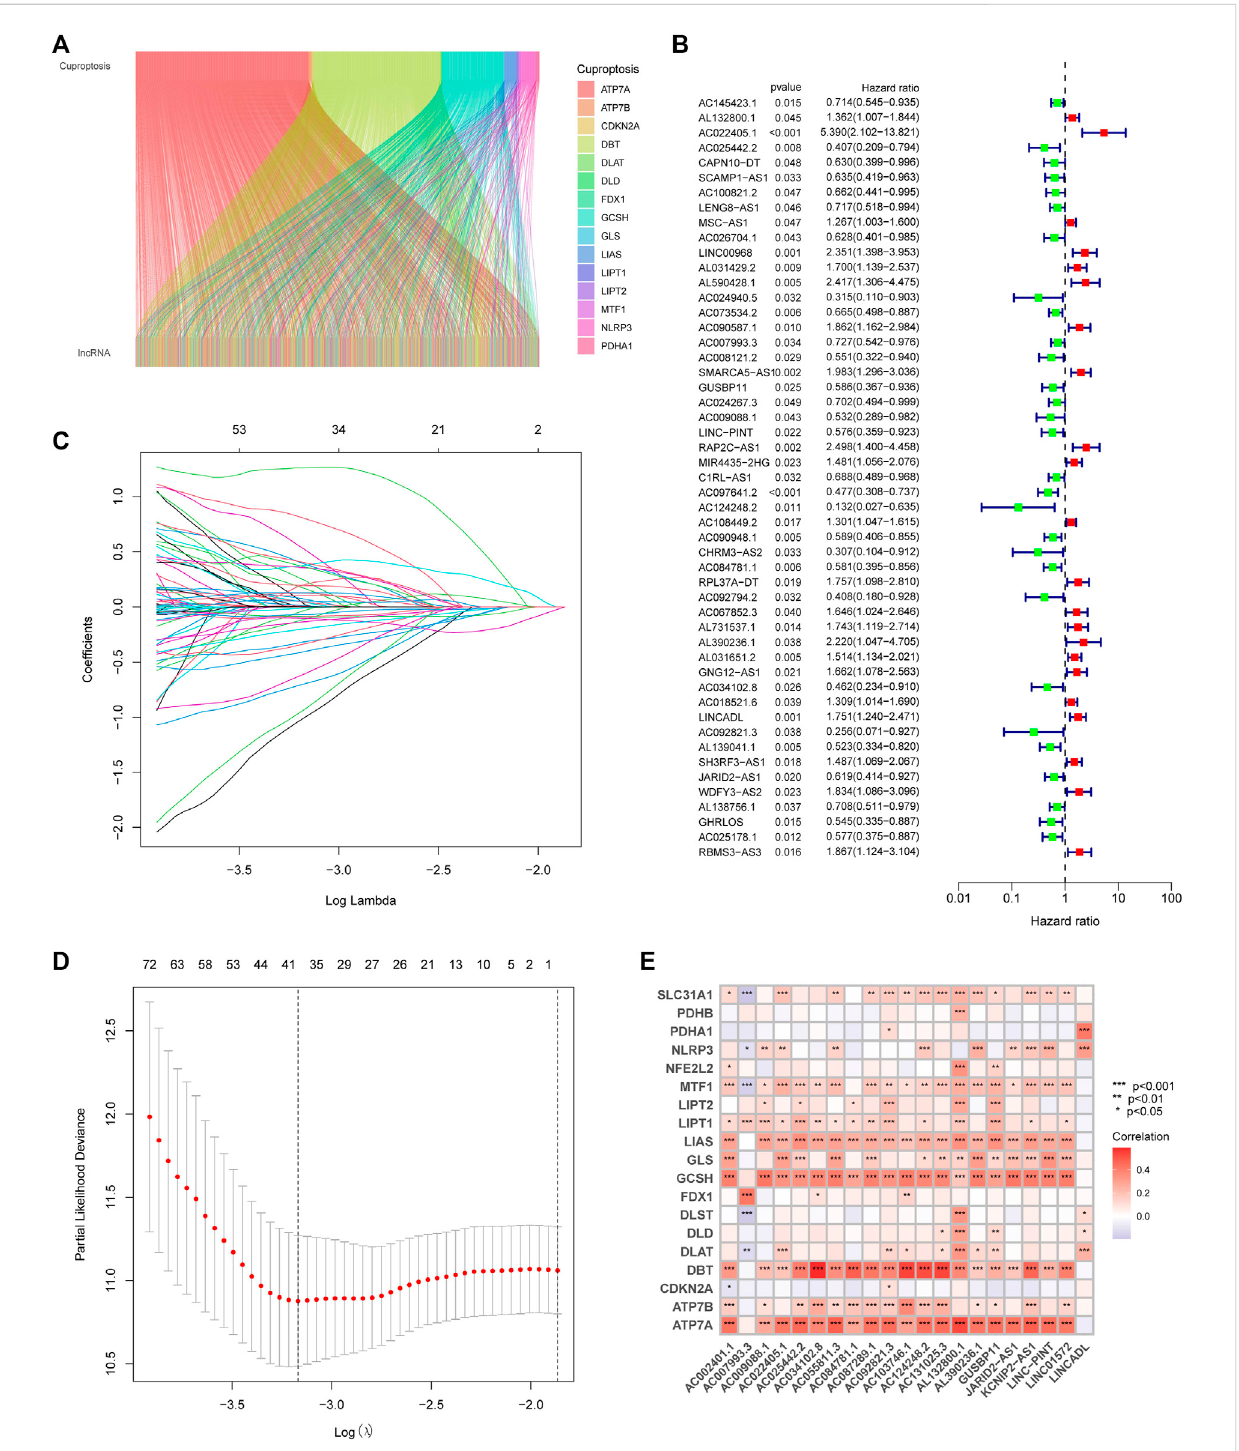
FIGURE 2 Construction of the CupRLSig model (A) The Sankey diagram shows the relevance between cuproptosis-related lncRNAs and cuproptosis-related genes (B) Forest plot showed different lncRNAs for high and low risk, with red representing high-risk lncRNAs and green representing low-risk lncRNAs (C) The 10-fold cross-validation of variable selection in the least absolute shrinkage and selection operator (LASSO) algorithm (D) Distribution of the LASSO coef fi cients of cuproptosis-related lncRNAs (E) A heatmap shows the association between the lncRNAs and 19